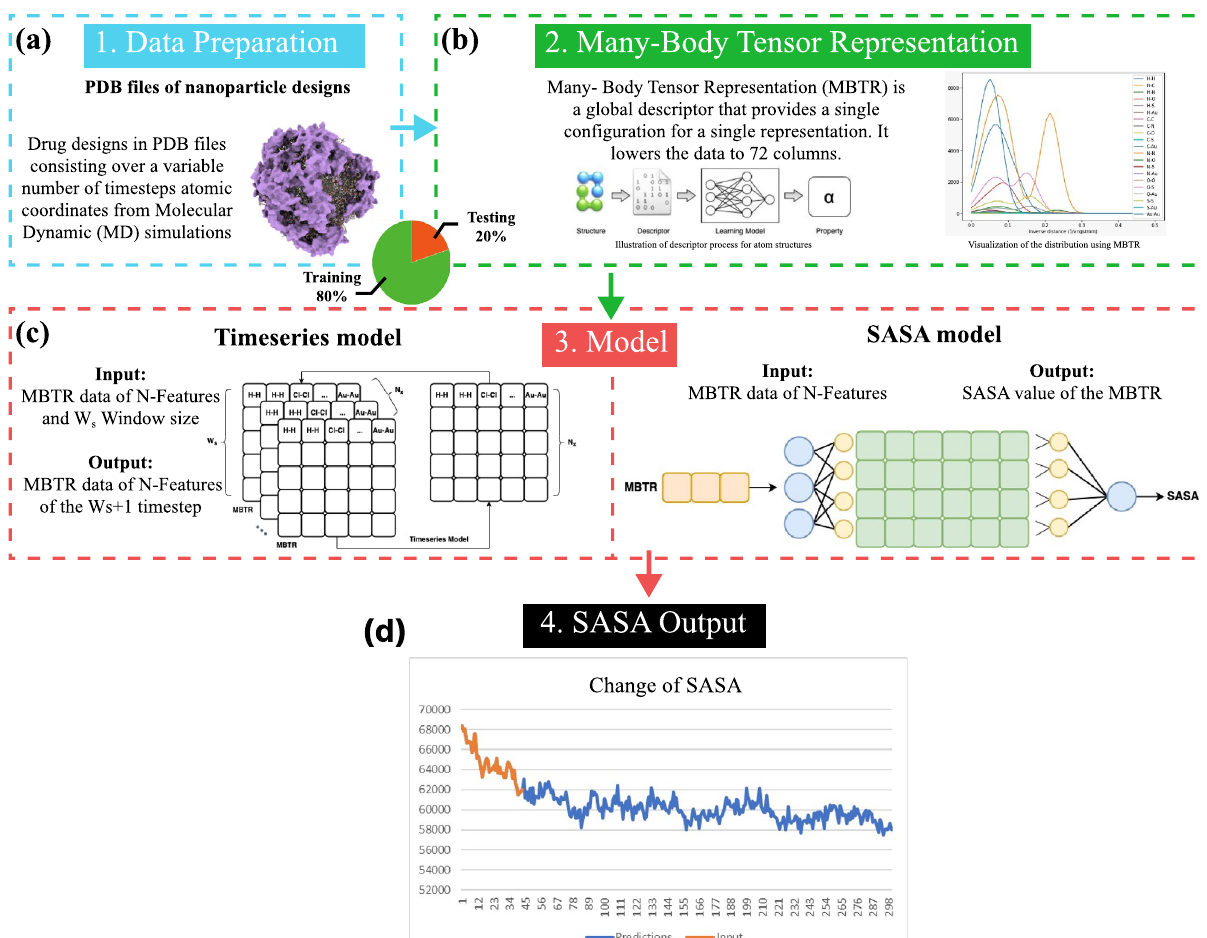
Figure 1. ML-based hybrid solution for the prediction of SASA values ( a ) Atomic coordinates for different NP designs derived from MD simulations in an aqueous environment. These data are in Protein Data Bank (PDB) format with other information such as the respective residues. ( b ) ML usable MBTR representation of the data extracted through a geometric function of pairwise distances between elements. ( c ) Time series model to accomplish the task of simulation and SASA model for the calculation of the target label. ( d ) A predefined batch of data can be used to forecast changes in the SASA. An optimal value for the size of this predefined batch can be set with consideration to the simulation costs for generating them and the error threshold (see Table 1). Although both the input and output of the models are the MBTR vectors except the final output, the graph represents the input-output relationship